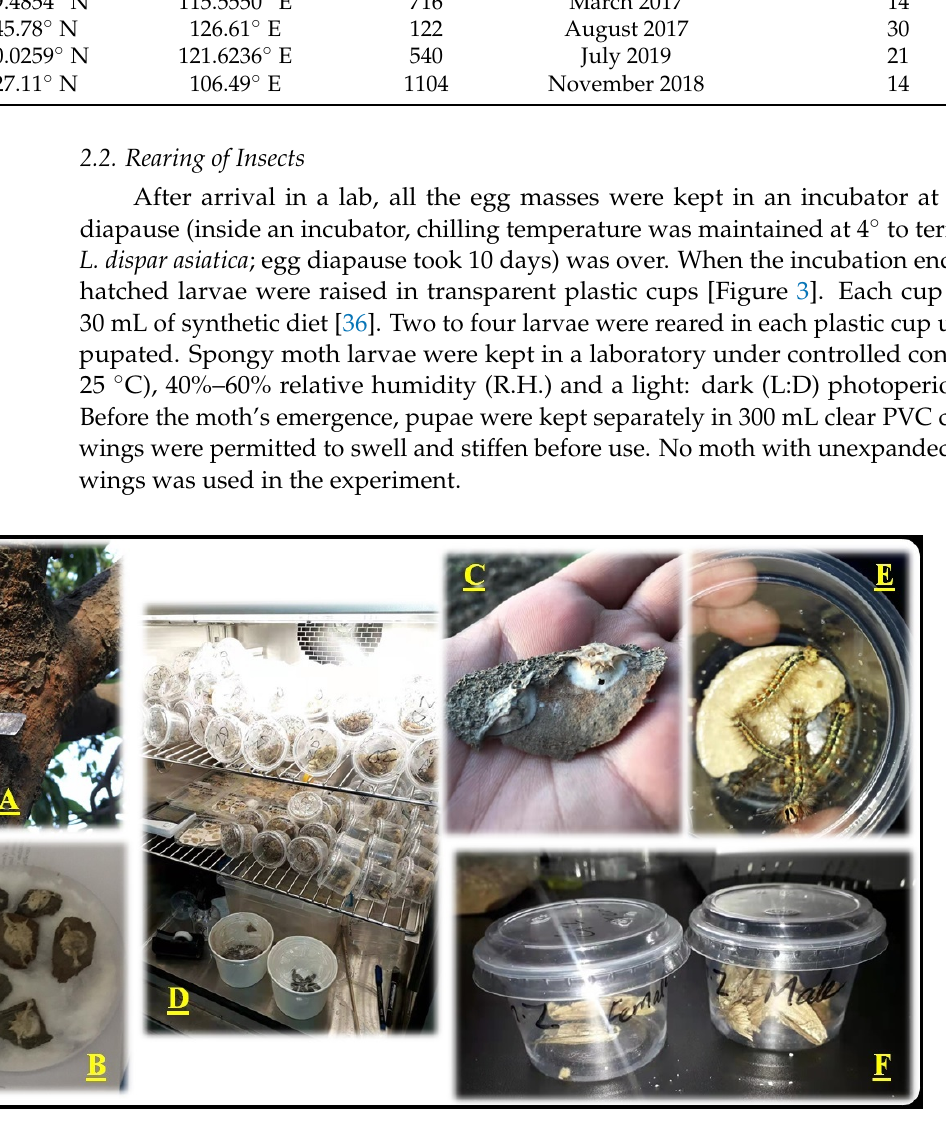
Figure 3. Images of Asian spongy moth ( L. dispar asiatica ) egg mass collection and rearing: ( A ) collection of egg masses from a tree trunk; ( B ) egg masses of L. dispar asiatica ; ( C ) a piece of bark containing egg masses of L. dispar asiatica ; ( D ) rearing of L. dispar asiatica larvae in the laboratory under controlled conditions; ( E ) a PVC container containing larvae of L. dispar asiatica feeding on an artificial diet; ( F ) PVC containers containing adult males and females of L. dispar asiatica .